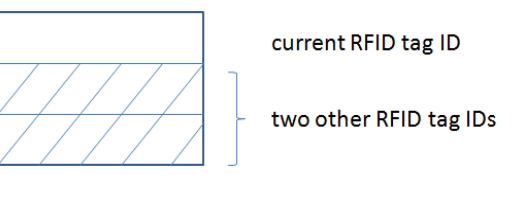
Figure 11. Signal format modification for target location determination.